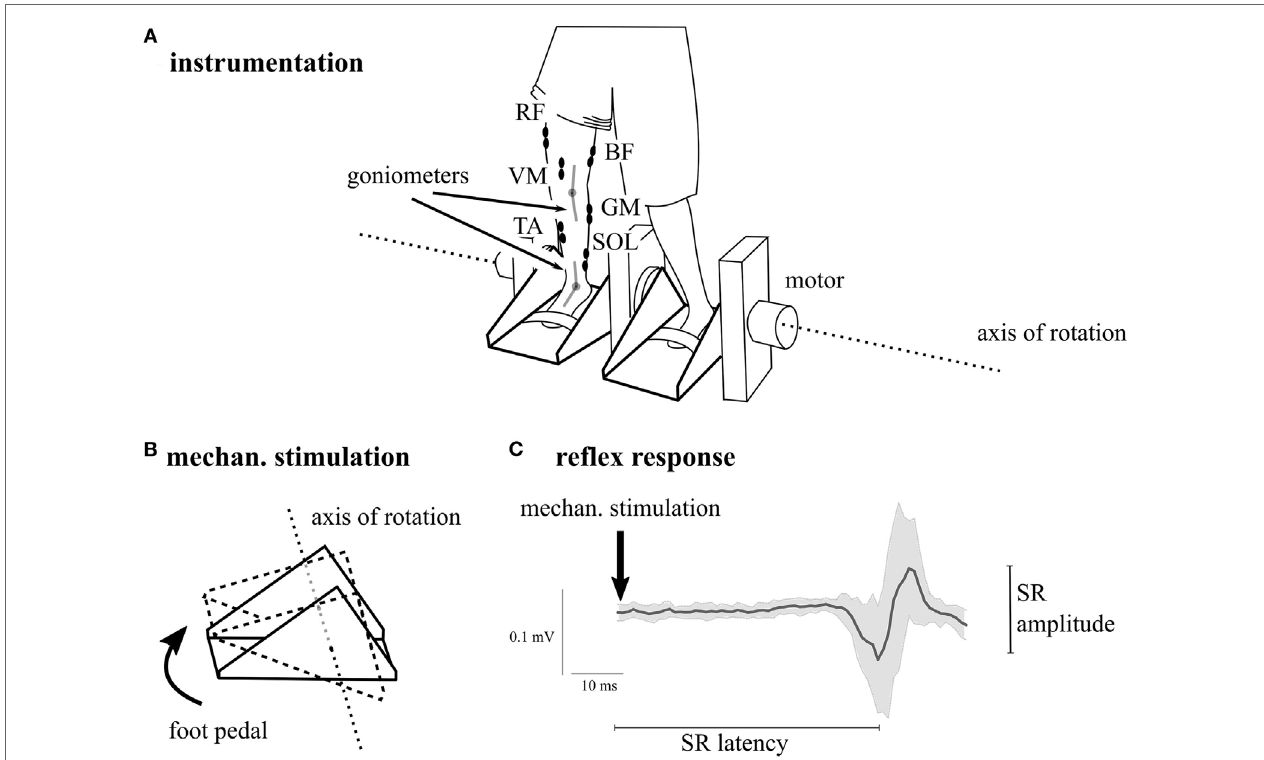
FigUre 1 | Illustration of the overall subject preparation and the instrumentation in Protocol 1 . The participant was prepared with surface electromyography of the lower limb muscles m. soleus (SOL), m. gastrocnemius medialis (GM), m. tibialis anterior (TA), m. rectus femoris (RF), m. vastus medialis (VM), and m. biceps femoris (BF) as well as electro-goniometry of the ankle and the knee joint. In Protocol 1 , stretch reflexes (SRs) were elicited mechanically by a dorsiflexion induced with the ankle ergometer (a,B) . Muscular responses (c) were recorded continuously; SDs are illustrated in